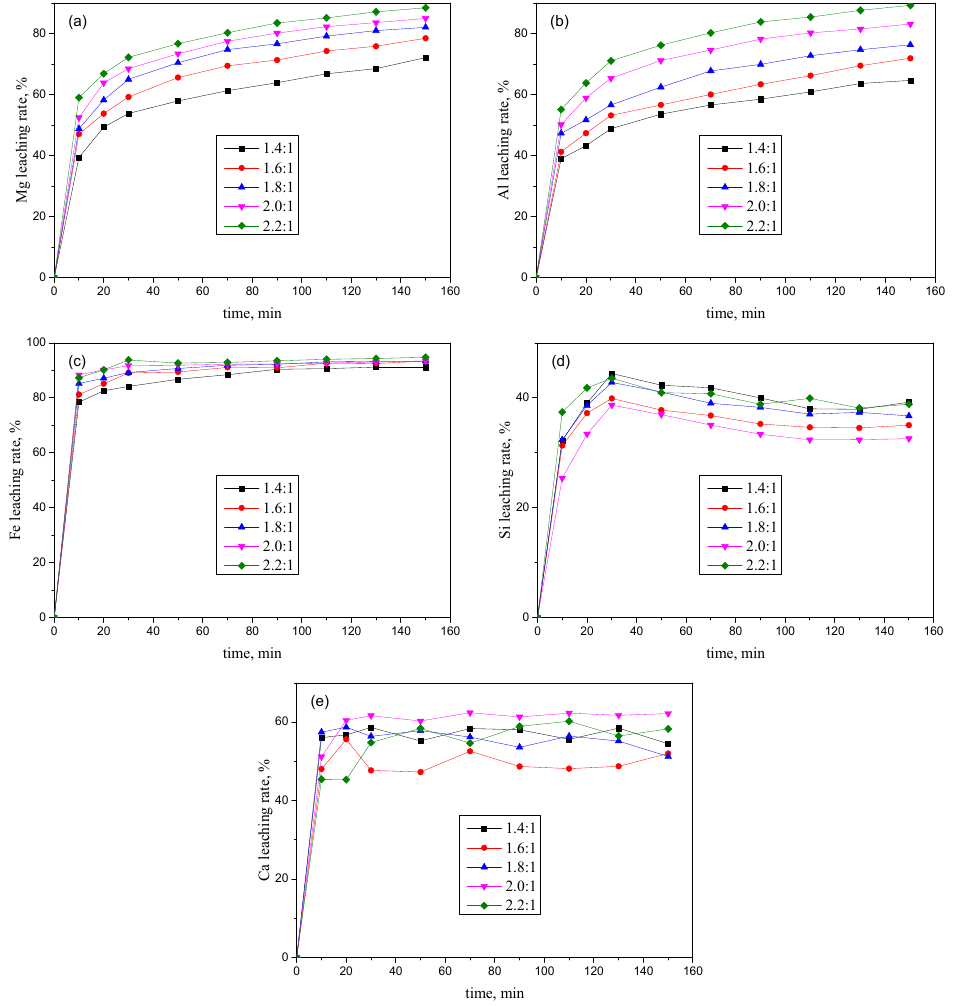
Figure 5. Effects of acid / solid weight ratio on the leaching of impurities: ( a ) Mg; ( b ) Al; ( c ) Fe; ( d ) Si; ( e ) Ca.